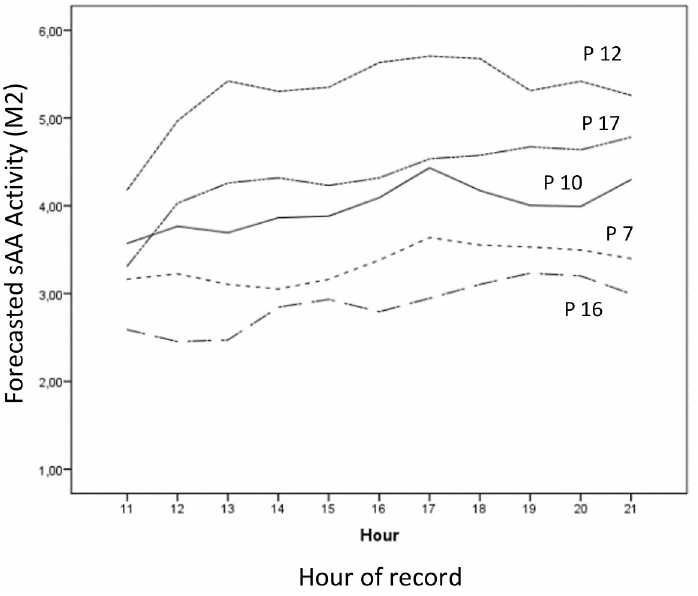
Fig 3. Forecasted sAA values of P7, P10, P12, P16 and P17, in agreement with Eq 10 ( M2 ), from 11:00 to 21:00 hr.